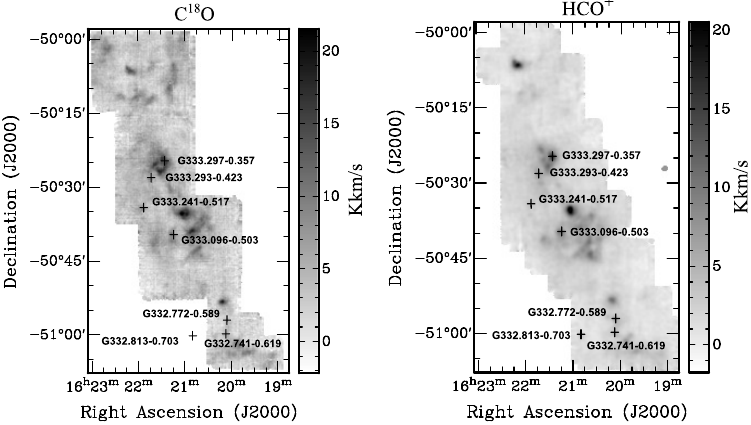
Fig. 3. C 18 O J = 1 ! 0 (left panel) and HCO + J = 1 ! 0 (right panel) integrated intensity (zeroth-moment) maps of the G 333 giant molecular cloud. The crosses